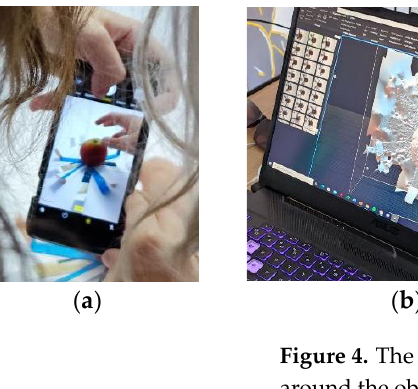
( d ) Figure 5. Students photographing outdoor elements and first good results ( a ) Location; ( b ) Details about structures; ( c ) Real wood piece; ( d ), Reconstruction. 3.1.1. Documented Students’ Workflow and Observations Our request was that students documented their workflow and note and observed each change they made from one iteration to another. This allowed all participants to no- tice when the technique needed alterations in terms of light, photography angles, motion, and stances, or even when the subject was not suited for the applied method. The authors found that this simple process of documentation was a valuable tool both in terms of activity management and advancement while teaching freshmen to work in teams, observe, evaluate, and adjust their own ongoing workflow. Thus, students gained independence and confidence in their technique, being able to perform very well during the second week of the workshop that was dedicated to individual study. As seen in Table 2, the first object choices as well as the strategy of building the three Light Boxes, both actions undergone at the beginning of the workshop, were very different from one team to another, while decisions taken later in the workshop tended to become more uni- form as students learned from each other ’ s mistakes and successes. Table 2. Students ’ observation worksheet summary. Team 1